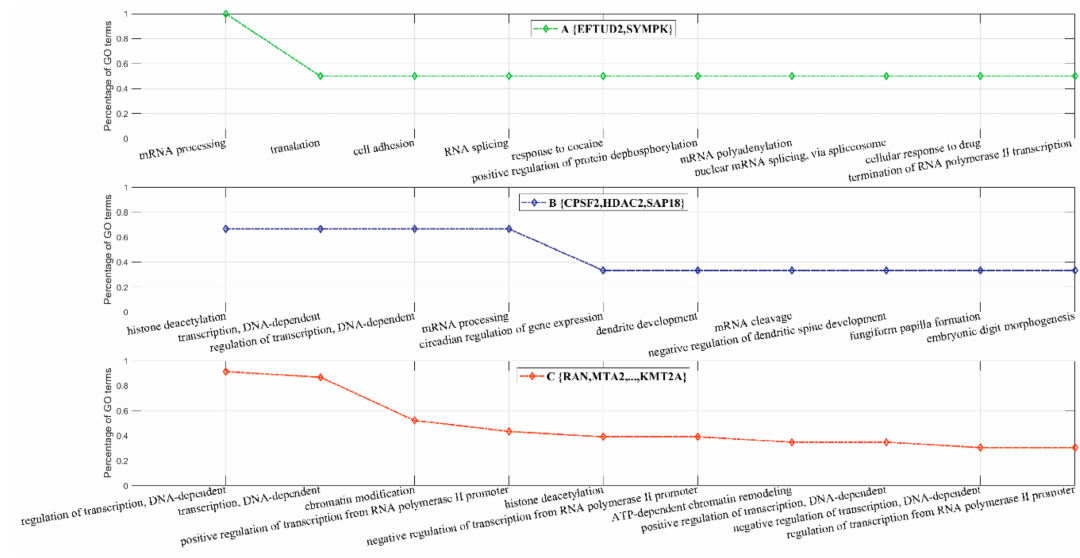
Figure 7. GO enrichment analysis of the GO semantically inferred sub-complexes within complete ALL-1 supercomplex (28 subunits). A . The sub-complex {EFTUD2,SYMPK}. B . The sub-complex {CPSF2,HDAC2,SAP18}. C . The sub-complex {RAN, MTA2, ... ,